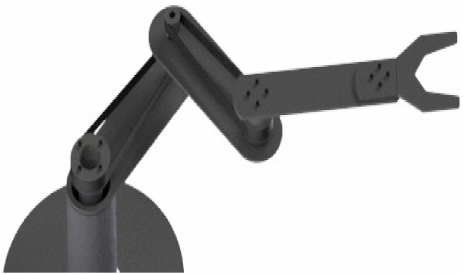
Figure 5. Description of R-movement for the proposed platform.